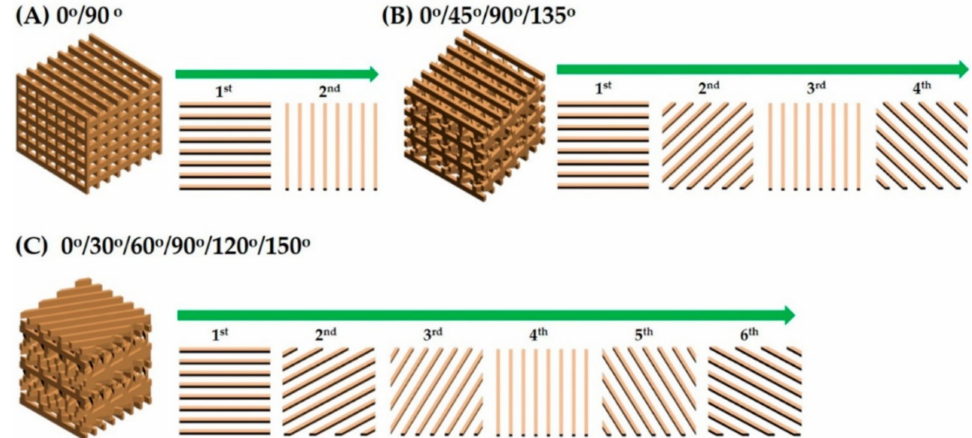
Figure 9. A schematic diagram showing the porous structures of various CaPO4 scaffolds with differ- ent pore orientations: ( A ) 0 ◦ /90 ◦ , ( B ) 0 ◦ /45 ◦ /90 ◦ /135 ◦ , and ( C ) 0 ◦ /30 ◦ /60 ◦ /90 ◦ /120 ◦ /150 ◦ , with their top-down view of the repeating CaPO4 frameworks. Reprinted from Ref. [481] with permission.